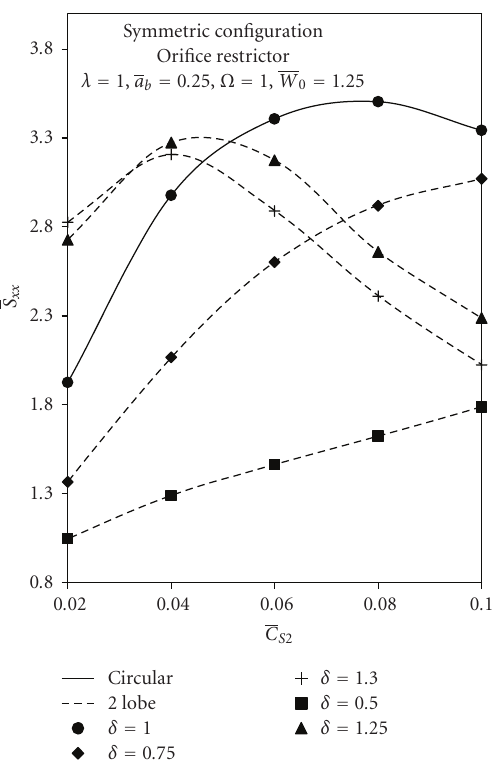
Figure 7: Variation of direct sti ff ness ( S xx ).